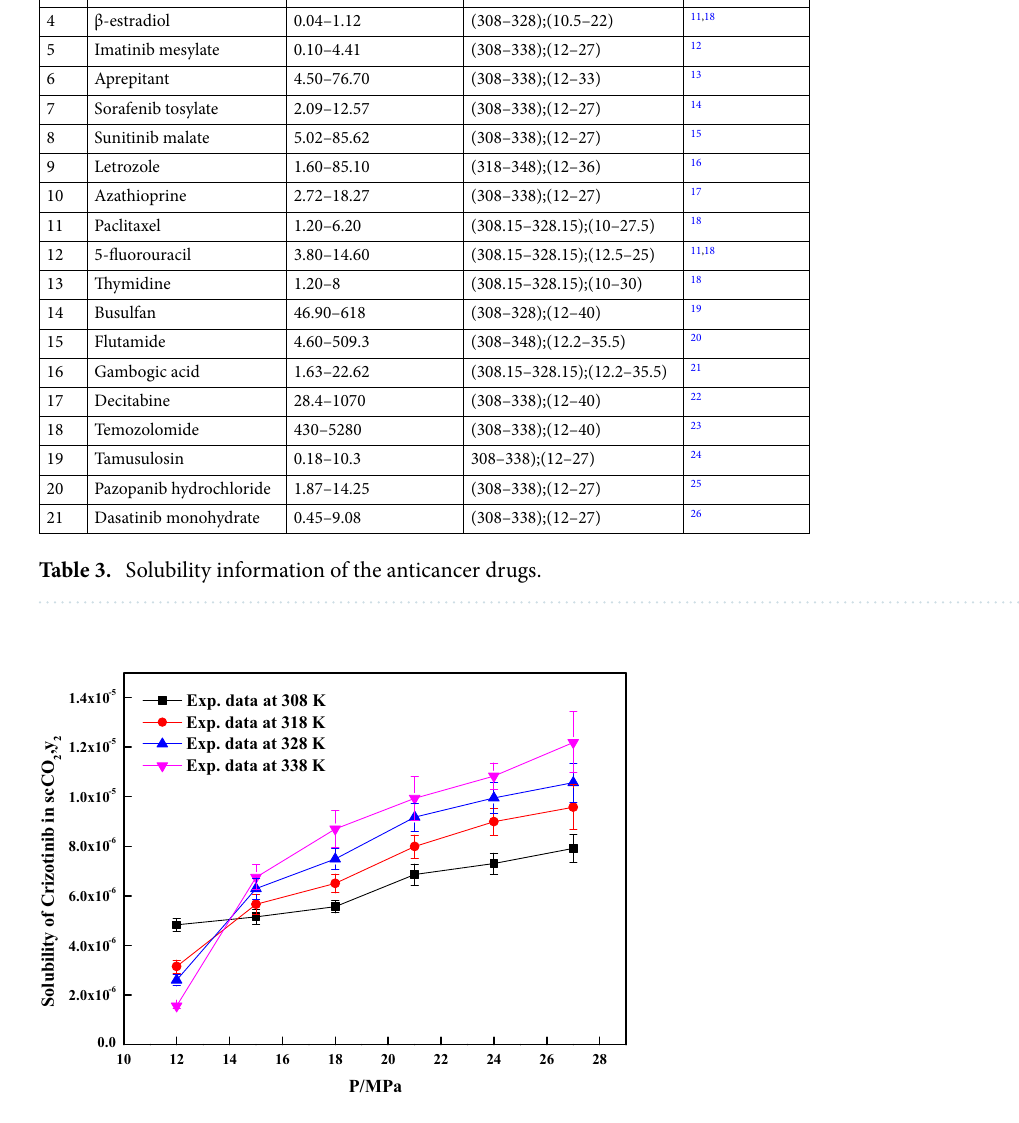
Figure 2. Solubility isotherms of Crizotinib in scCO 2